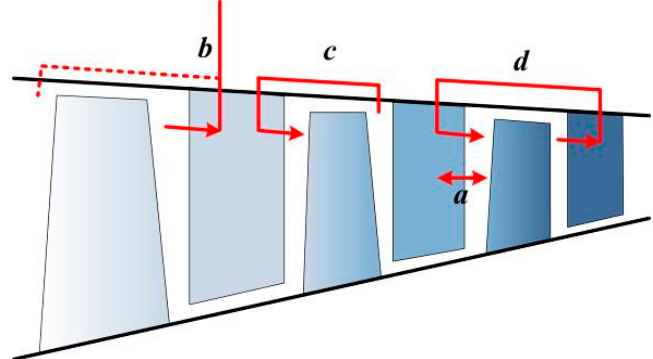
Figure 1. Schematic diagram of typical unsteady flow control schemes ( a . synthetic jet; b . unsteady aspiration; c . pulsed jet; and, d . the combination of unsteady aspiration and pulsed jet).